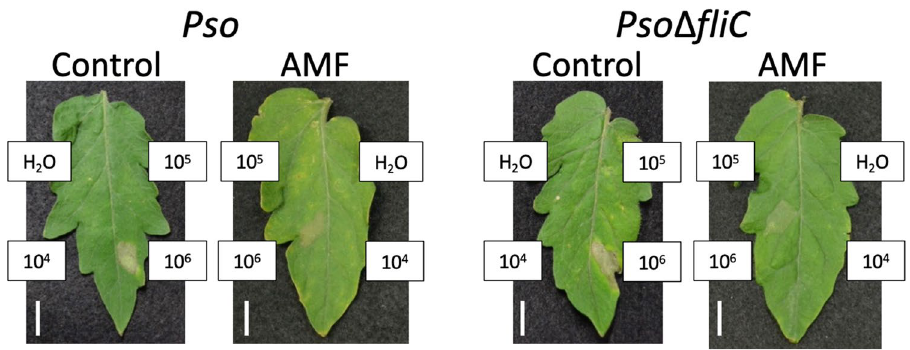
Figure 4. Response of tomato leaves to infection with avirulent pathogens. Tomato plants were inoculated with G. margarita (25 spores/pot) for 14 days. Terminal leaflets of the 4th leaves of 3-week-old tomato plants were inoculated with Pso or Pso∆fliC (1 × 10 4 , 1 × 10 5 , or 1 × 10 6 CFU/ml) or water (H 2 O). Each experiment was done with more than 4 plants. Photographs were taken 30 h after inoculation. The experiment was repeated twice with similar results. Control, water-treated plants; AMF, G. margarita -colonized